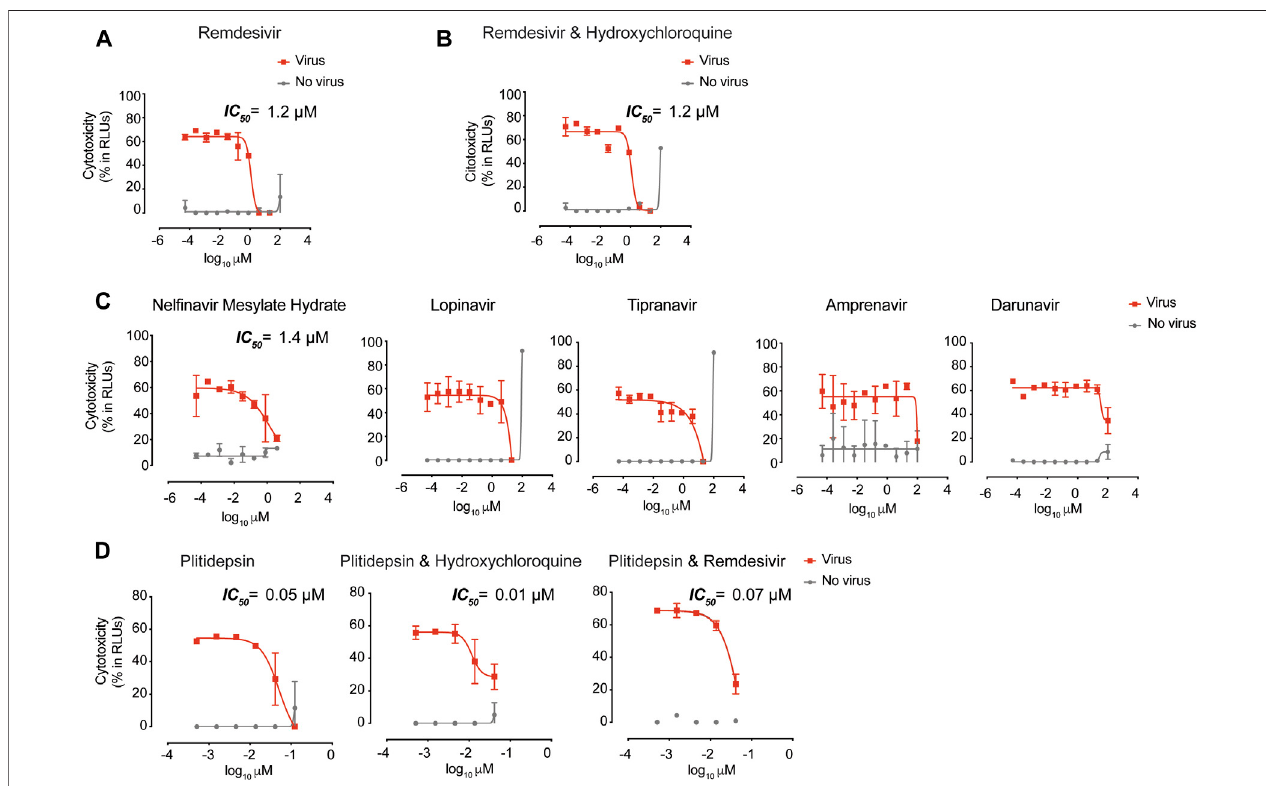
FIGURE 2 | Antiviral activity of post-entry inhibitors. (A) Cytopathic effect on Vero E6 cells exposed to a fi xed concentration of SARS-CoV-2 in the presence of increasing concentrations of Remdesivir. Drug was used at a concentration ranging from 0.0512 nM to 100 μ M. Non-linear fi t to a variable response curve from one representativeexperimentwithtworeplicatesisshown(redlines),excludingdatafromdrugconcentrationswithassociatedtoxicity.TheparticularIC 50 valueofthisgraph isindicated.CytotoxiceffectonVeroE6cellsexposedtoincreasingconcentrationsofdrugsintheabsenceofvirusisalsoshown(greylines). (B) .Cytopathic effect on Vero E6 cells exposed to a fi xed concentration of SARS-CoV-2 in the presence of increasing concentrations of remdesivir and its combination with hydroxychloroquine, asdetailed in (A) . Drugs incombination were used at aconcentration ranging from 0.0512 nM to100 μ M (left panel). (C) . Cytopathic effect on Vero E6 cells exposed to a fi xed concentration of SARS-CoV-2 in the presence of increasing concentrations of protease inhibitors against HIV-1. Nel fi navir mesylate hydrate was the only drug with activity. Inhibitors were used at a concentration ranging from 0.0512 nM to 100 μ M. The particular IC 50 value of this graph is indicated (D) . Cytopathiceffect onVeroE6cellsexposed toa fi xedconcentrationofSARS-CoV-2inthepresence ofincreasingconcentrationsofplitidepsin andits combinationswith hydroxychloroquine and remdesivir. When combined, each drug was added at the same concentration. Drugs were used at a concentration ranging from 0.5 nM to 10 μ M. The particular IC 50 value of these graphs is